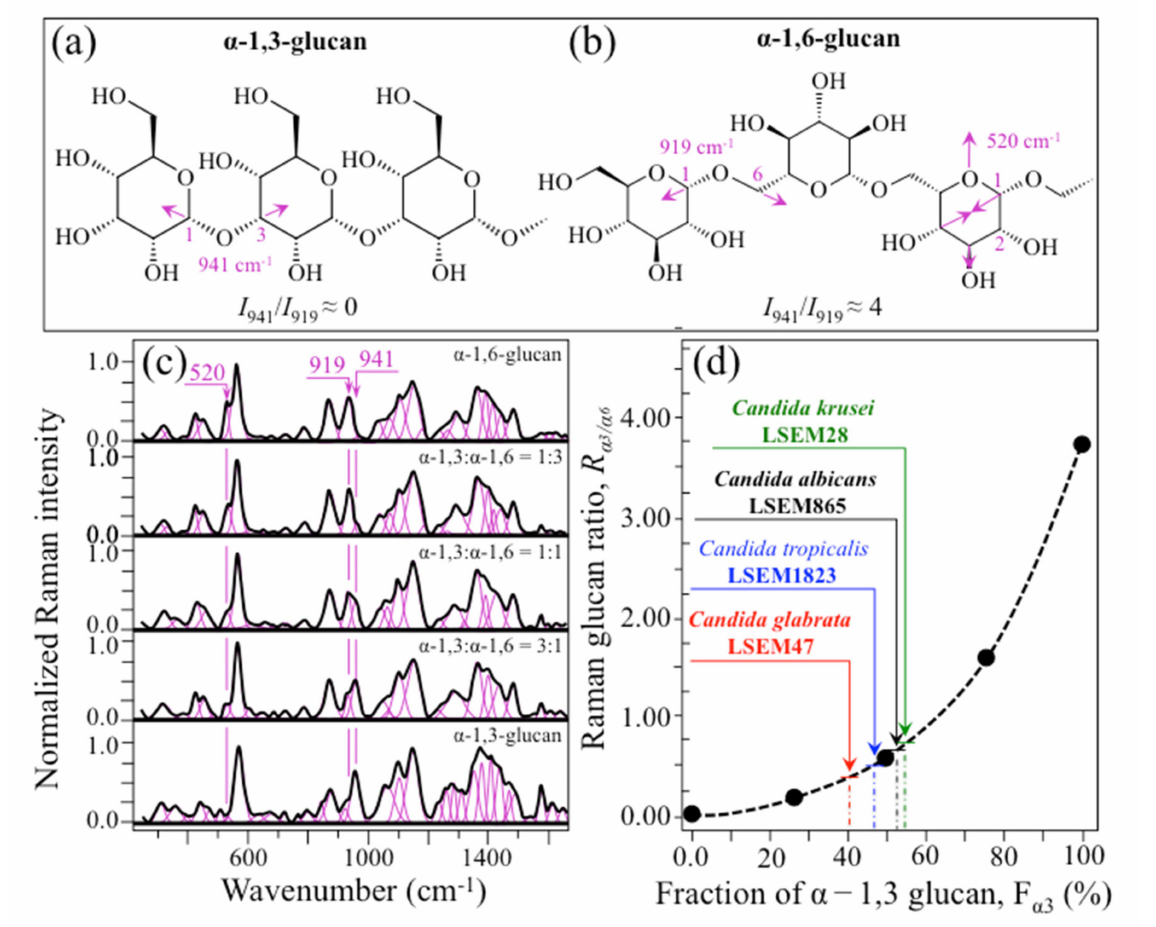
Figure 4. Structures of ( a ) α -1, 3-glucans and ( b ) α -1, 6-glucans with their respective vibrational fingerprints; ( c ) Raman spectra of α -1, 6- and α -1, 3-glucans and their mixtures, and ( d ) the obtained calibration plot linking the Raman intensity ratio, R α 3/ α 6 = I 941 / I 919 , to the α -1, 3-glucan fraction, F α 3 , from which the glucan structures of the studied Candida species are evaluated (cf.